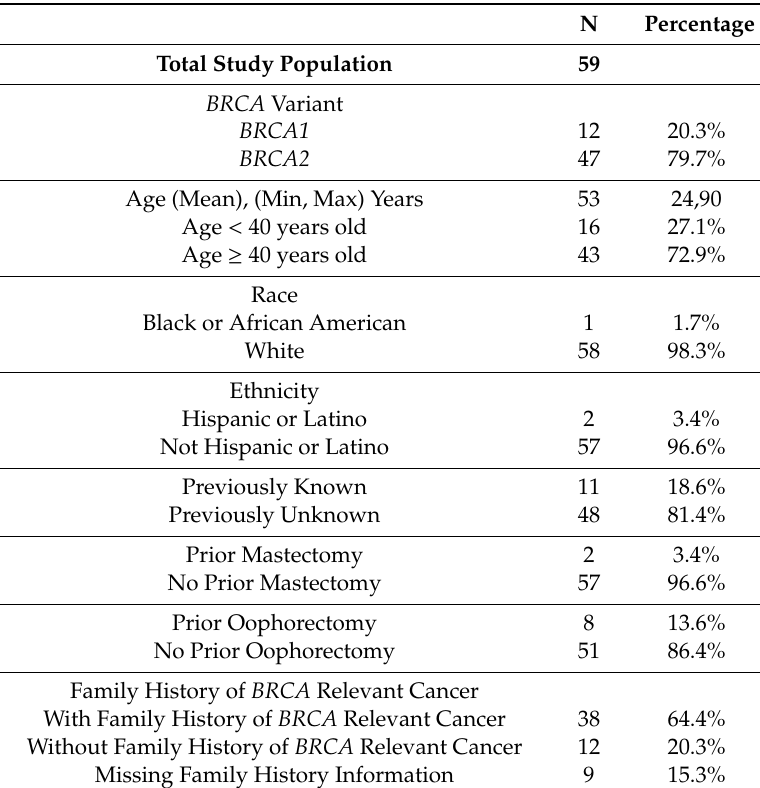
Table 1. Demographic